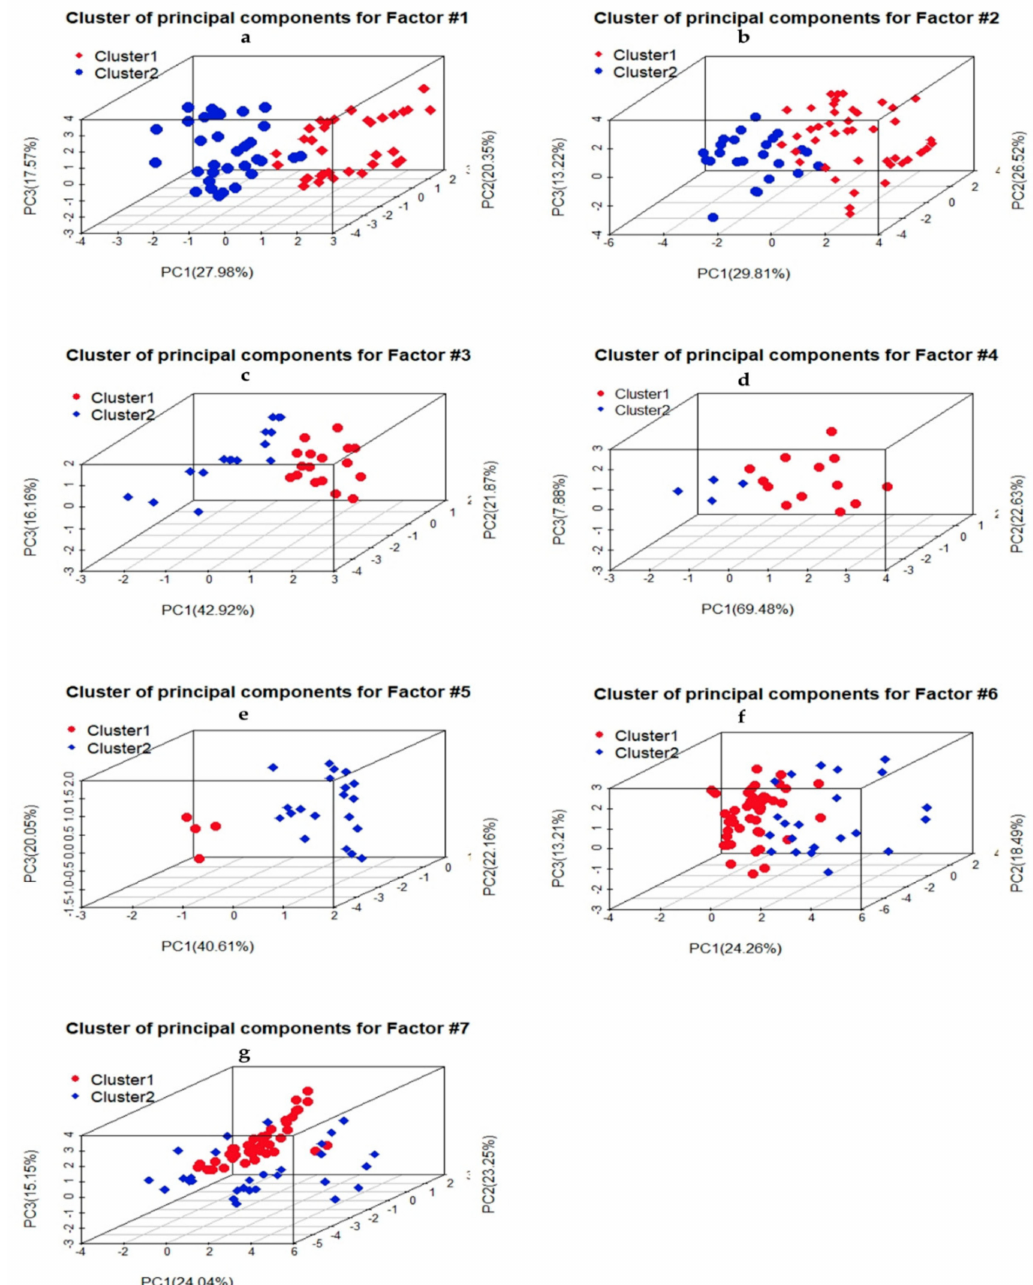
Figure 7. A cluster based on hydrologic position of basin states (i.e., cluster 1 and cluster 2 represent upstream and downstream countries, respectively), where ( a ) is experts response division on indicators under factor-#1—called geography, hydrology, ecology, and natural features, ( b ) factor-#2—socio-economic needs of basin states, ( c ) factor-#3—the population dependent on the watercourse, ( d ) factor-#4—the e ff ects of water use, ( e ) factor-#5—existing and potential uses, ( f ) factor-#6—costs of conservation and protection, and ( g ) factor-#7—availability of alternative and comparable values and